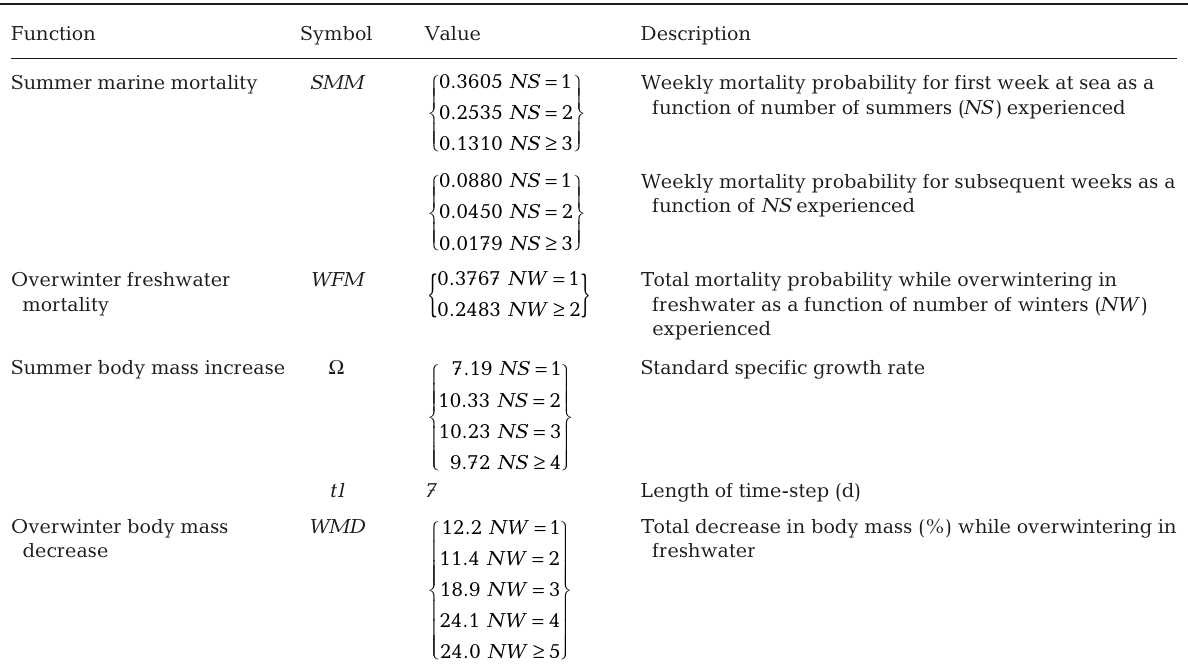
Table 4. Parameters of background mortality and body mass